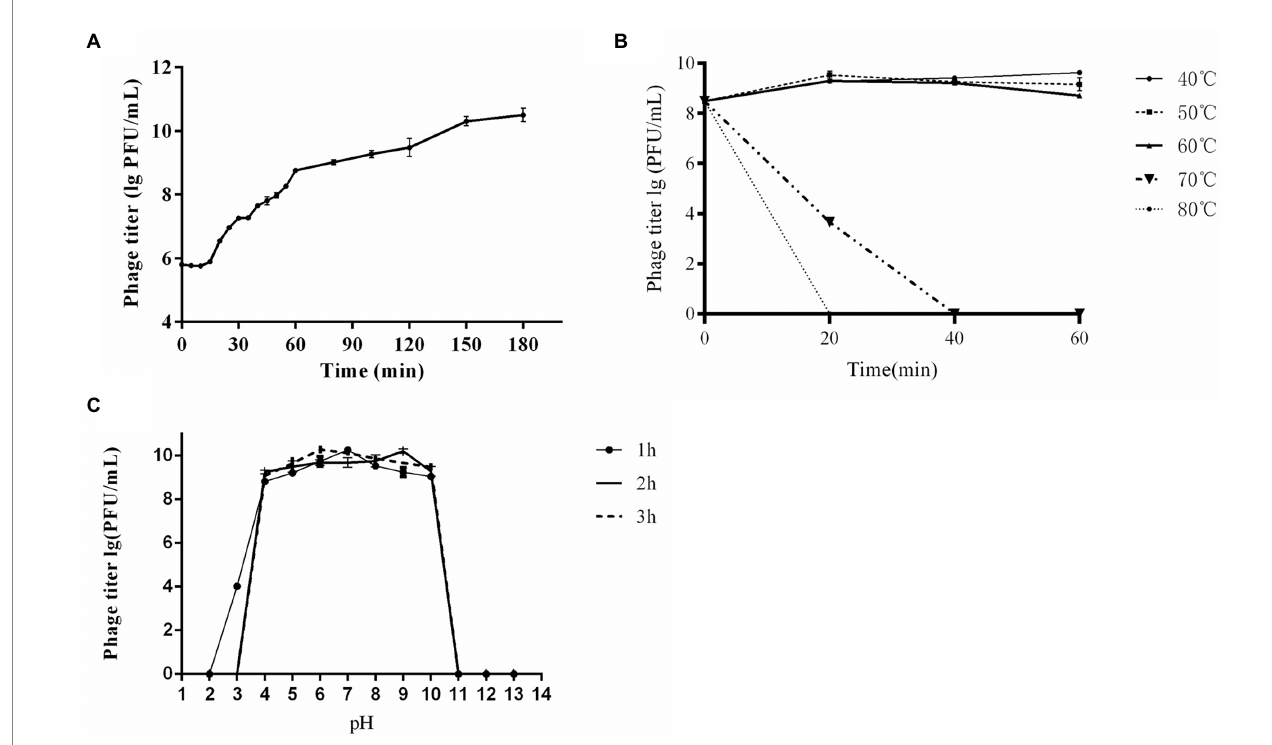
FIGURE 2 Biological properties of phage CE1. One-step growth curve of phage CE1. The data were expressed as means ± SD (n = 3) (A) ; Sensitivity of CE1 to temperature. There was little effect on the activity of CE1 when the temperature varied from 40 ° C to 60 ° C for 1 h, while CE1 was quickly inactivated when the temperature rose to 70 ° C for 40 min or 80 ° C for 20 min. (B) ; Sensitivity of CE1 to pH. Phage CE1 was relatively stable within the pH range of 4 to 10 when incubated at different pH values (2 to 13) for 3 h (C)